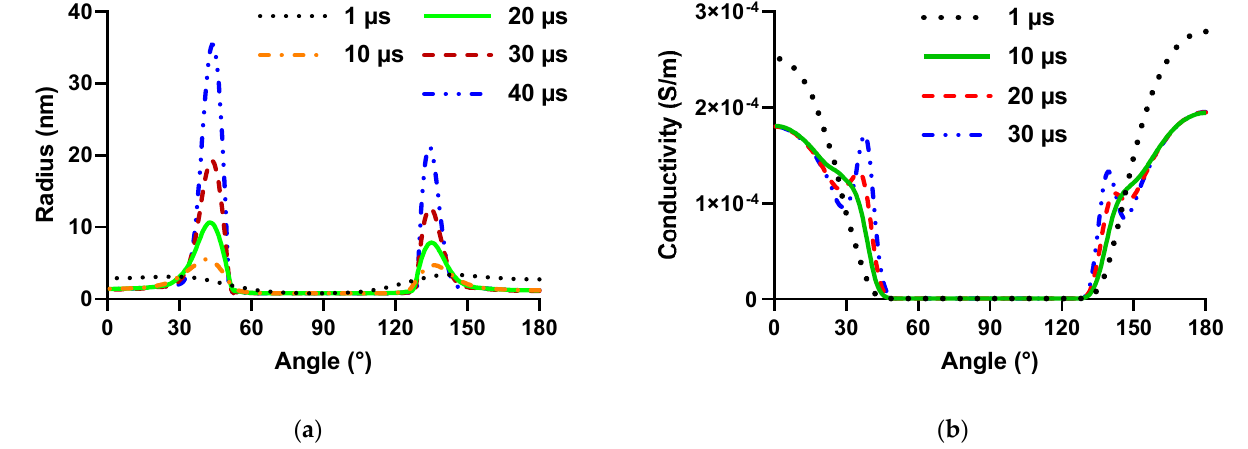
Figure 4. The changes of ( a ) pore radius and ( b ) conductivity along the semi-circumference from 0°~180° at different moments using 1-1-1 protocol with 1000 V/cm.